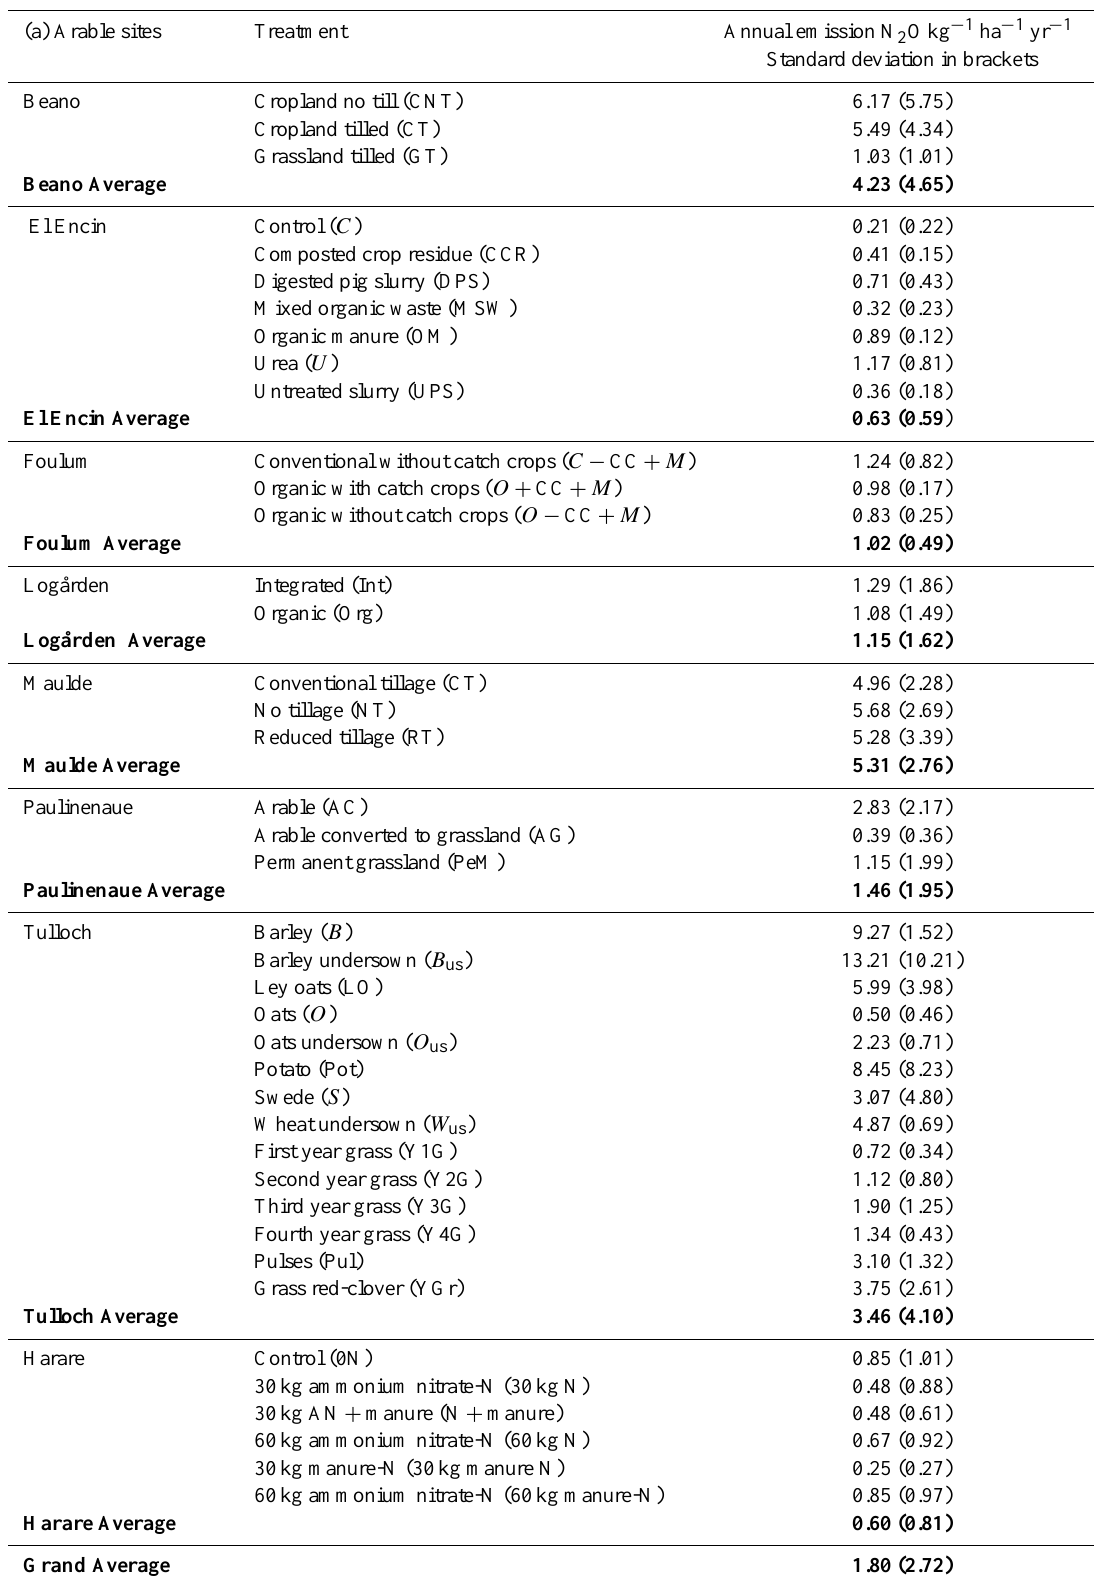
Table 3 . Nitrous oxide emissions (annual total) in response to site and management conditions across the experimental network classified by site and